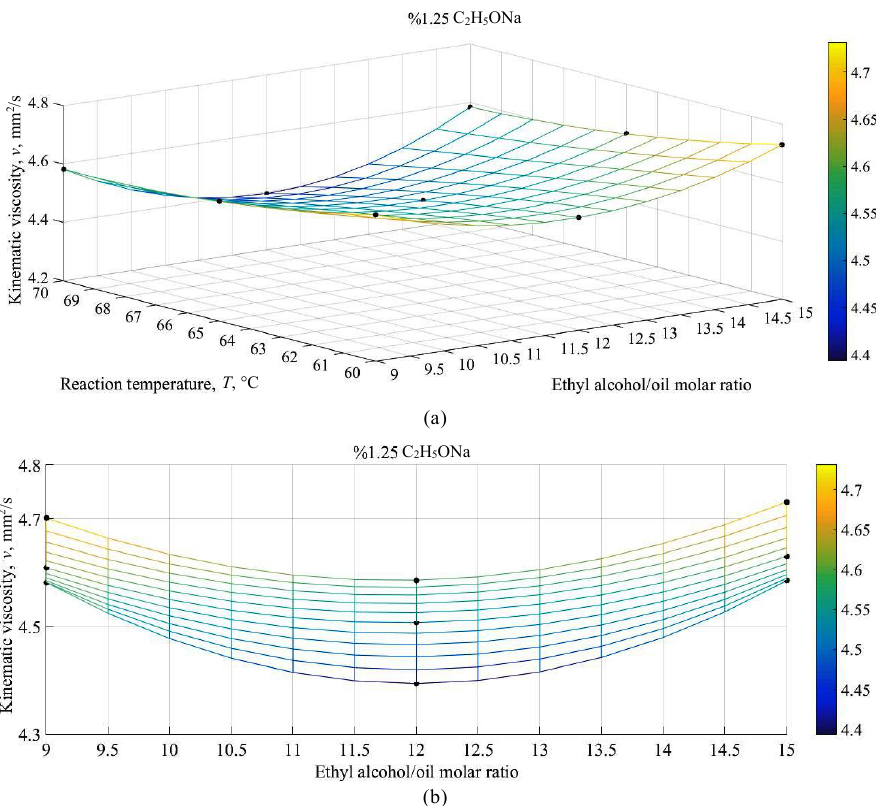
2D Fig. 1–6(c) show the individual effect of reaction temperature on viscosities of methyl and ethyl esters produced using different catalyst concentrations (0.75 %, 1.00 % and 1.25 %). As reaction temperature is increased, the transesterification, as an endothermic reaction, shifts to ester side (i.e. conversion yield to biodiesel increases), and viscosities of methyl and ethyl esters diminish until 56 °C and 70 °C at which the values reach minimums, given above for all catalyst concentrations, respectively. However, higher reaction temperatures than 56 °C and 70 °C cause a decrease in the reaction yield because of evaporation of alcohol from the reaction medium, saponification and decomposition, resulting in the increase in viscosities of methyl and ethyl esters. The variation in viscosities of methyl esters with respect to reaction temperature occurs in a more narrow range when the catalyst concentration of 1.00 % is used, compared to 0.75 % and 1.25 %, as seen in 2D Fig. 1–3(c). In addition, the interval of variation in viscosity values of ethyl esters vs. reaction temperature nearly remains for 1.00 % and 1.25 % while the interval decreases for 0.75 % catalyst concentration as the reaction temperature is raised, as seen in Fig.